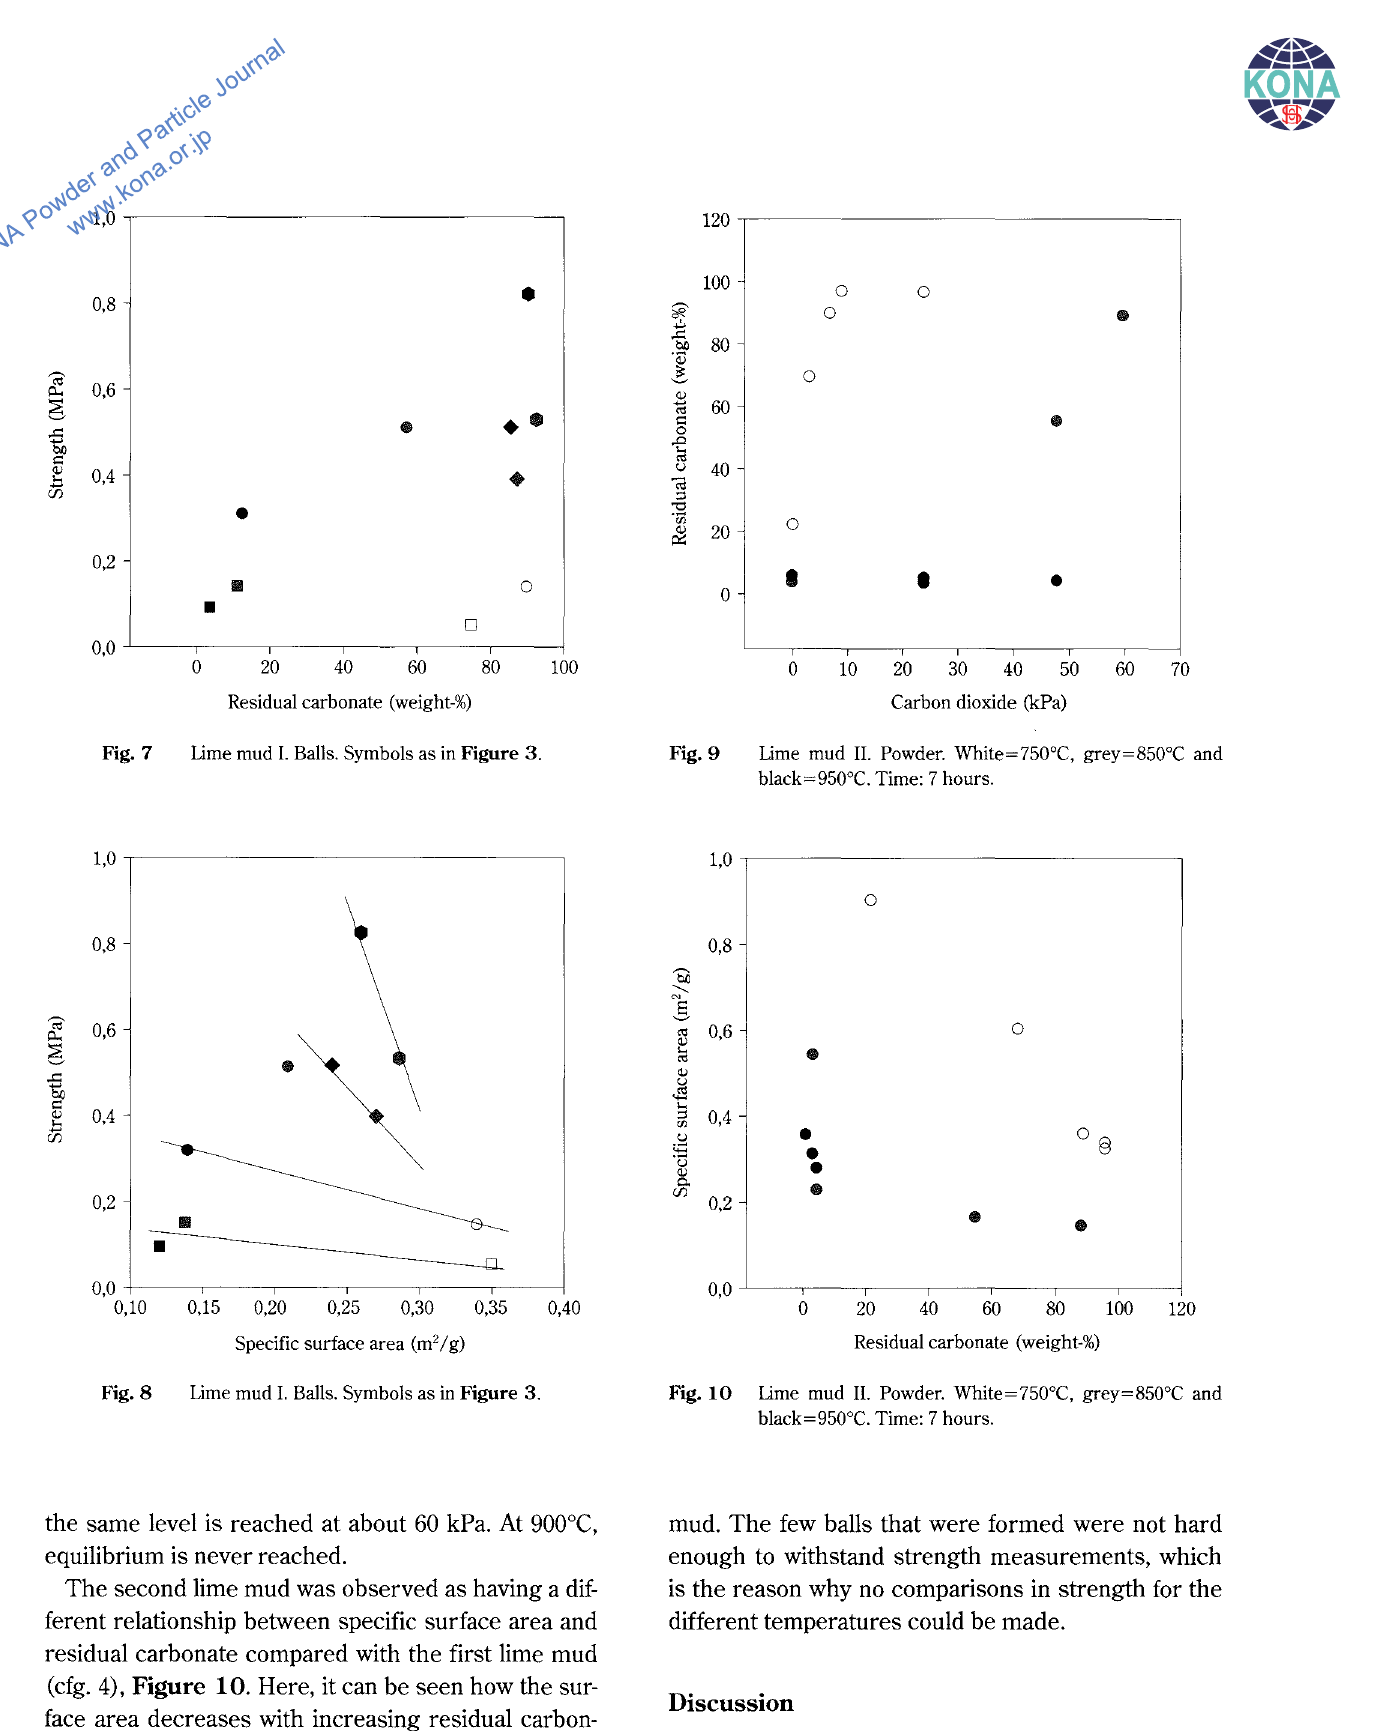
Fig.8 Lime mud I. Balls. Symbols as in Figure 3.